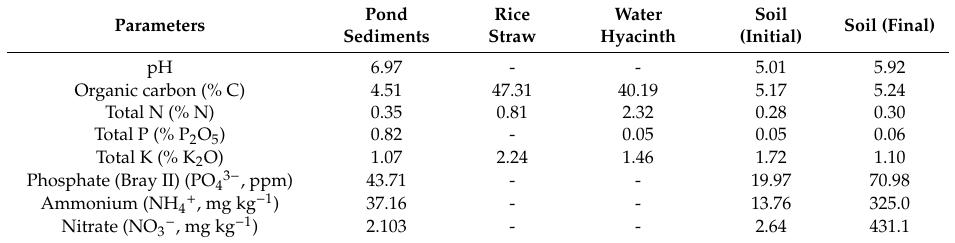
Table 1. Chemical composition of Pangasius pond sediments, rice straw, and common water hyacinth used in the first experiment, and soil where cucumber was grown before and after the second experiment.